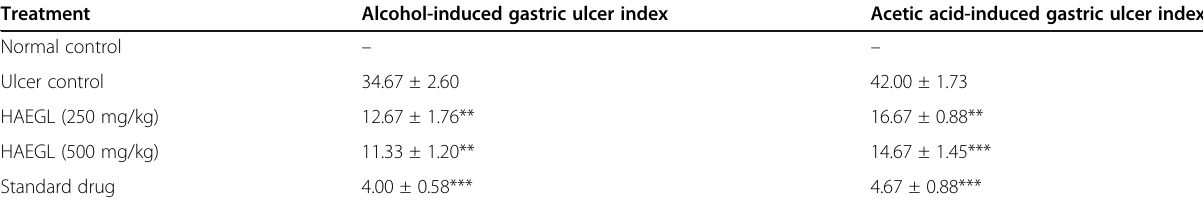
Table 8 Effect of HAEGL on alcohol-induced and acetic acid-induced gastric ulcer on rats